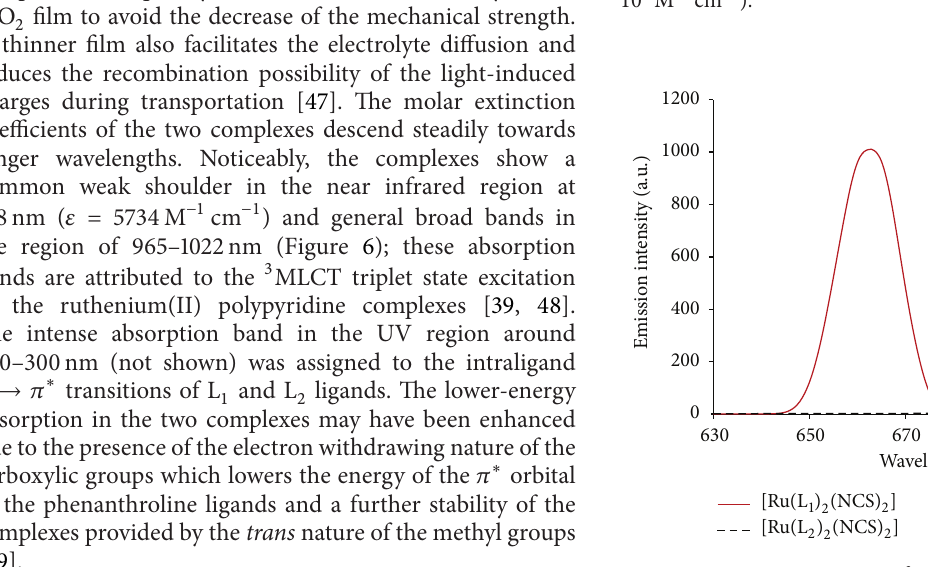
Figure 7: Comparison of the emission spectrum of [Ru(L 1 ) 2 (NCS) 2 ] (solid line) with [Ru(L 2 ) 2 (NCS) 2 ] (dash line) at a concentration of 1 × 10 −3 M −1 in DMF solution showing effect of extended 𝜋 -conjugation using